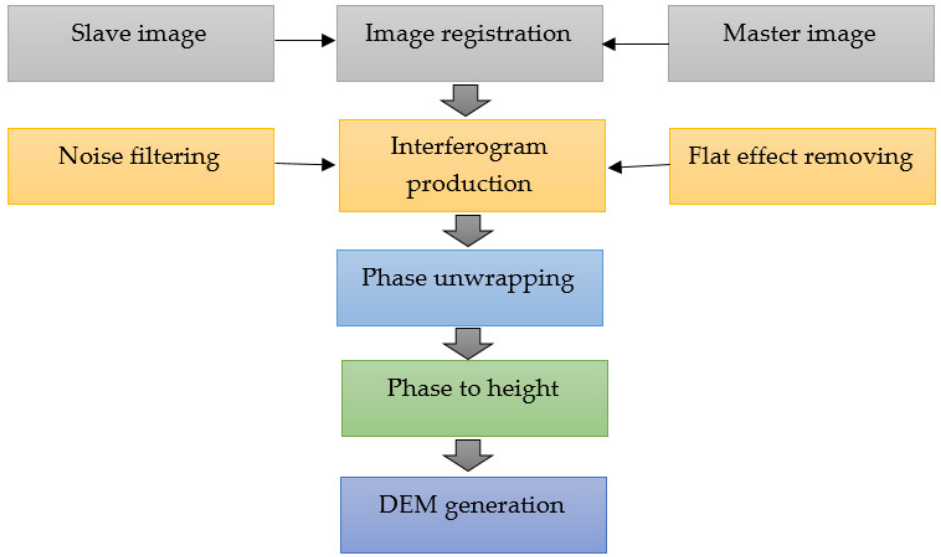
Figure 3. Interferometric synthetic aperture radar (InSAR) data-processing procedure for digital elevation model (DEM) production.